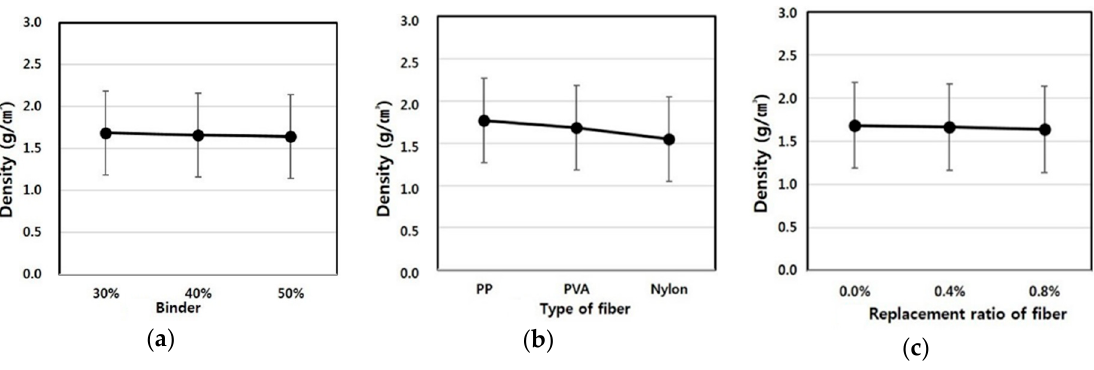
Figure 6. Assumed dry density of the extrusion panel by variance analysis: ( a ) replacement ratio of binder; ( b ) type of fiber; ( c ) replacement ratio of fiber.